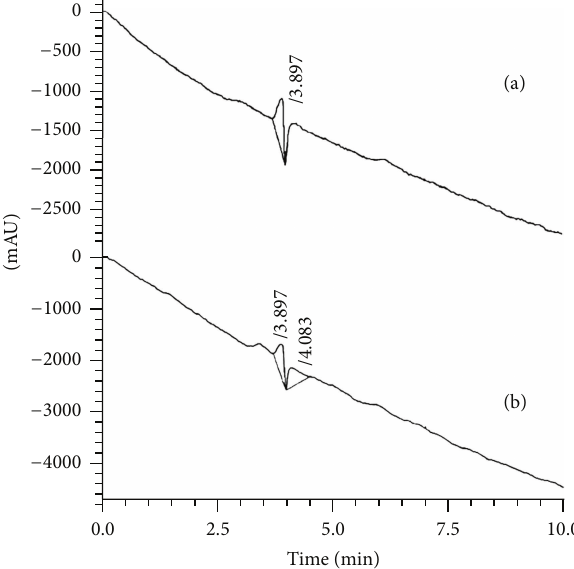
Figure 16: HPLC chromatograph showing the degradation of 2,4,6- TNP.